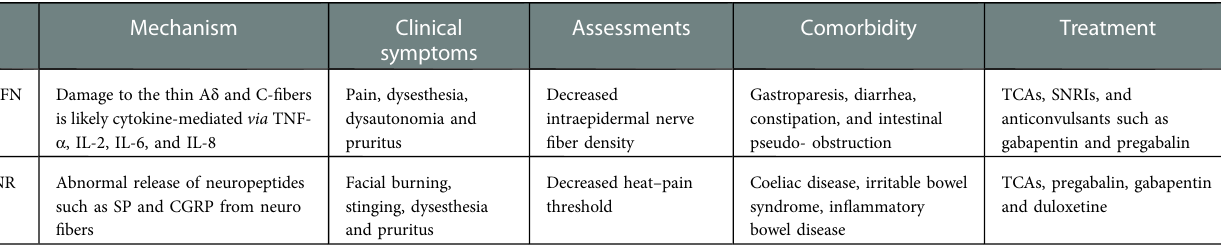
TABLE 1 Common characteristics between small fi ber neuropathy and neurogenic